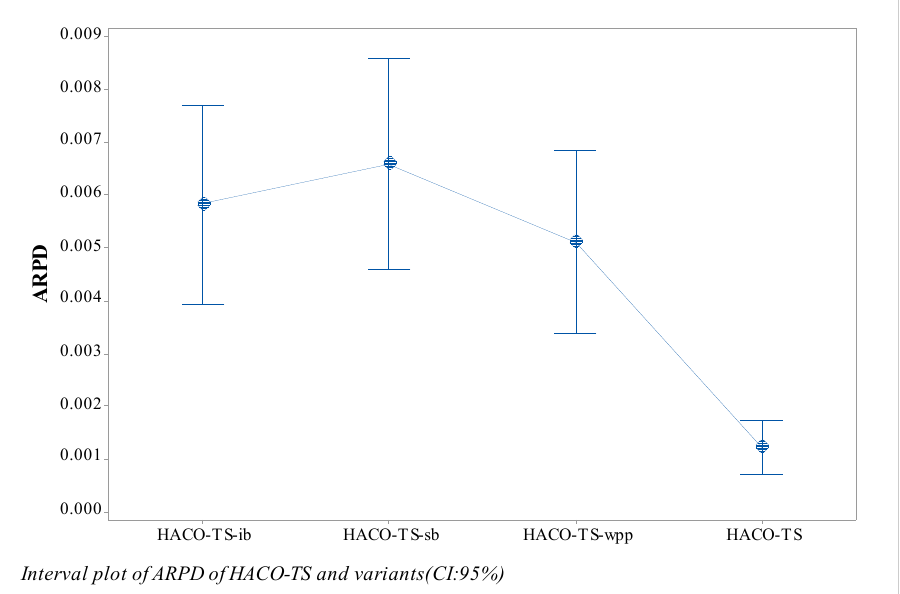
Fig. 7. Interval plot of ARPD of HACO-TS and